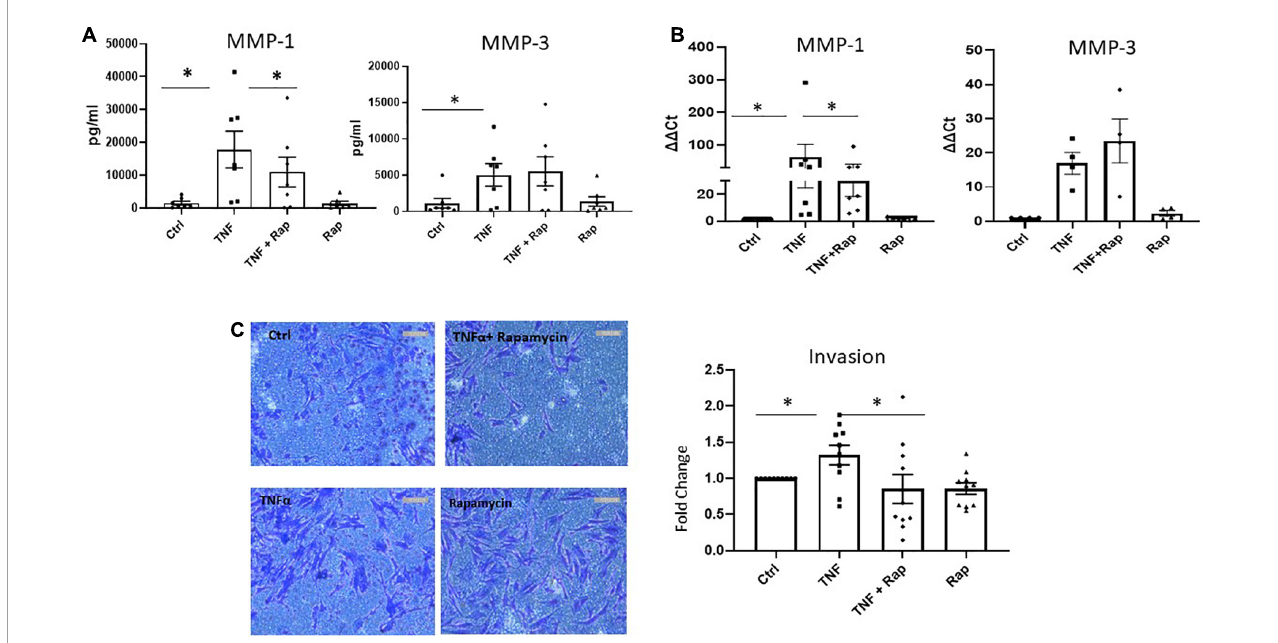
FIGURE4 mTOR inhibition in RA synovial fibroblasts decreases cellular invasion. (A) Bar graphs showing the measured secretion of MMP-1 and MMP-3 from RASF cultured in the presence of TNF α (1 ng/ml) and Rapamycin (100 nM) alone or in combination for 24 h ( n = 7). (B) Bar graphs showing gene expression of MMP-1 and MMP-3 from RASF ( n = 4–7). Gene expression analysis quantified using Real-time PCR. Fold increase compared to endogenous controls (RPLPO and HPRT1). (C) Representative photomicrographs of RASF invasion along with accompanying bar graph quantifying invasion ( n = 10). Following 48 h stimulation, invading cells attached to lower membrane were fixed (1% paraformaldehyde) and stained (0.1% crystal violet). Values expressed as mean ± SEM, Friedman Test with Dunn’s multiple comparison and Wilcoxon signed rank test used for RASF. ∗ p <